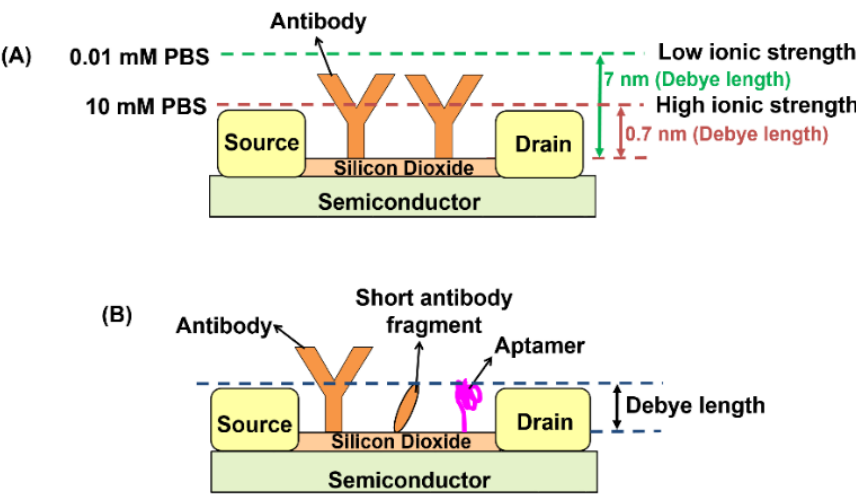
Figure 9. ( A ) The Debye length increases with the reduction of buffer ionic strength. ( B ) Short antibody fragments or aptamers could be used to bring the analyte-binding closer to the sensor surface and within the Debye